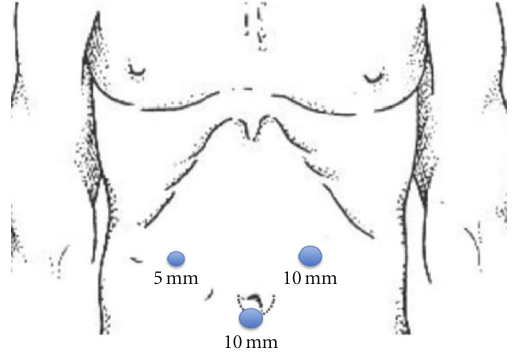
Figure 1: Abdominal CT showing a peripheral lipomatous lesion in left lateral sector.